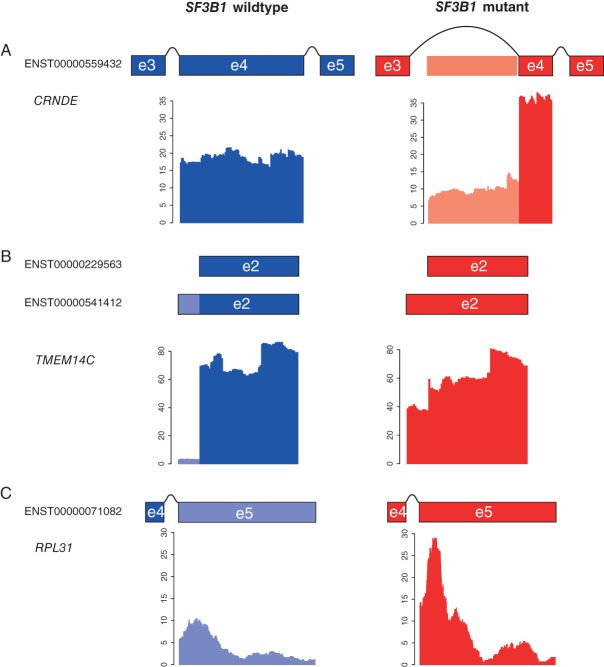
Identification of differential splicing in SF3B1 mutant (n = 3) and wild-type (n = 11) papillary carcinomas of the breast. Plots of normalised RNA-sequencing reads for (A) CRNDE, (B) TMEM14C, and (C) RPL31 in SF3B1 wild-type (blue) and SF3B1 mutant (red) tumours. Schematic representations of the exon structures are shown above the graph, with exons represented by boxes. Differentially spliced exon bins are indicated by lighter coloured shading. Box plots representing the validation of the differential splicing event in wild-type (blue) versus mutant (red) tumours by quantitative RT-PCR.